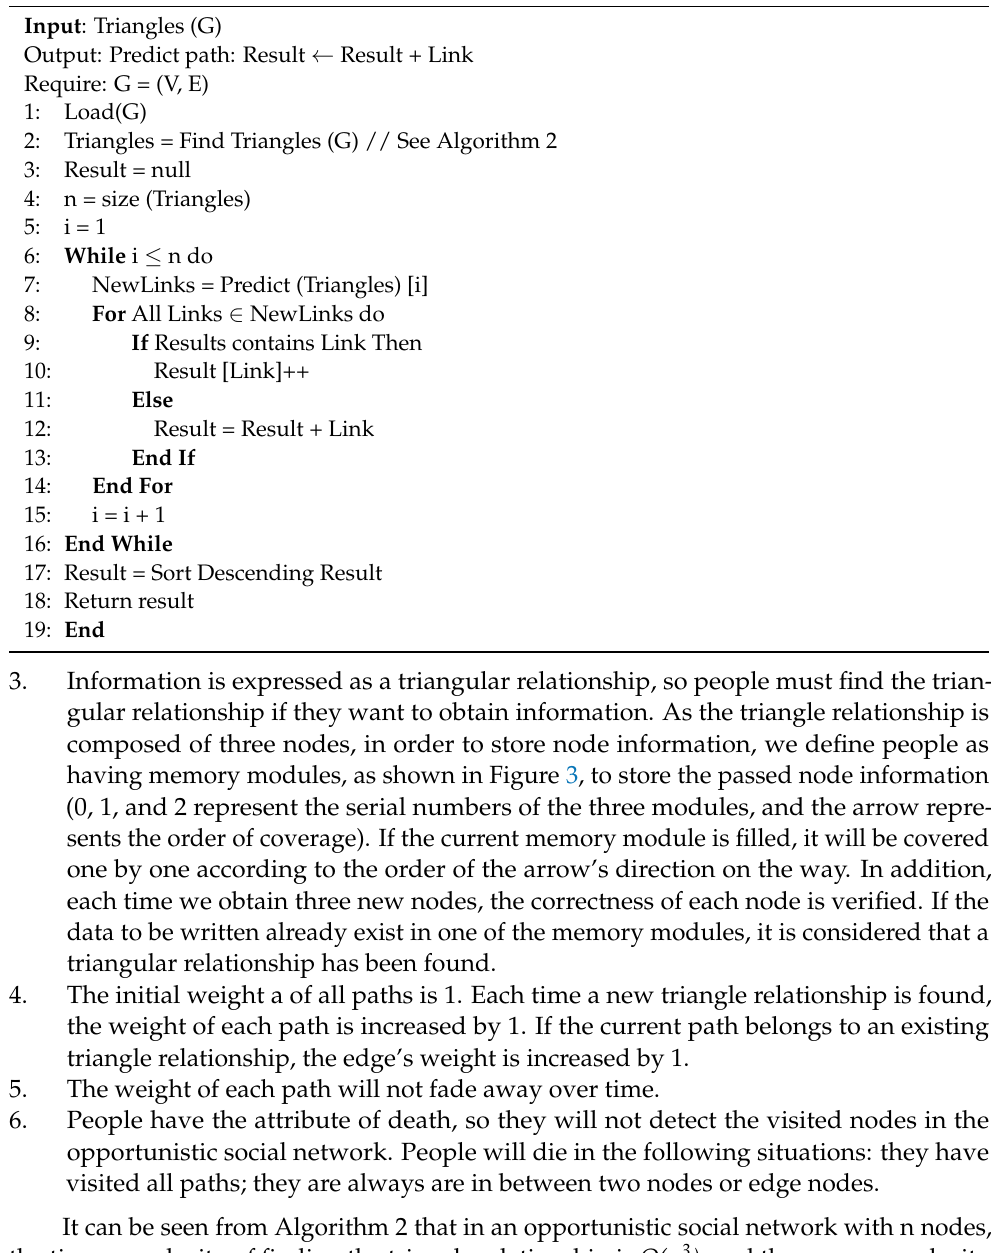
Algorithm 1. LPMBT, Link prediction model based on